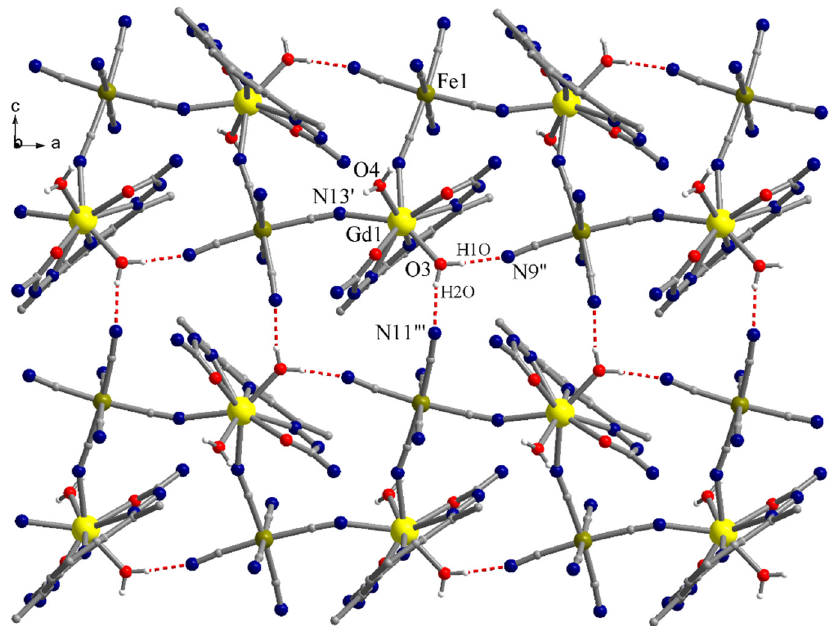
Figure 2. View along the crystallographic b axis of the packing diagram of compound 1 GdFe showing a supramolecular layer (symmetry codes: ’ = − 0.5 + x, 0.5 − y, 1 − z; ” = 0.5 + x, 0.5 − y, 1 − z; ”’ = x, 0.5 − y, − 0.5 + z).